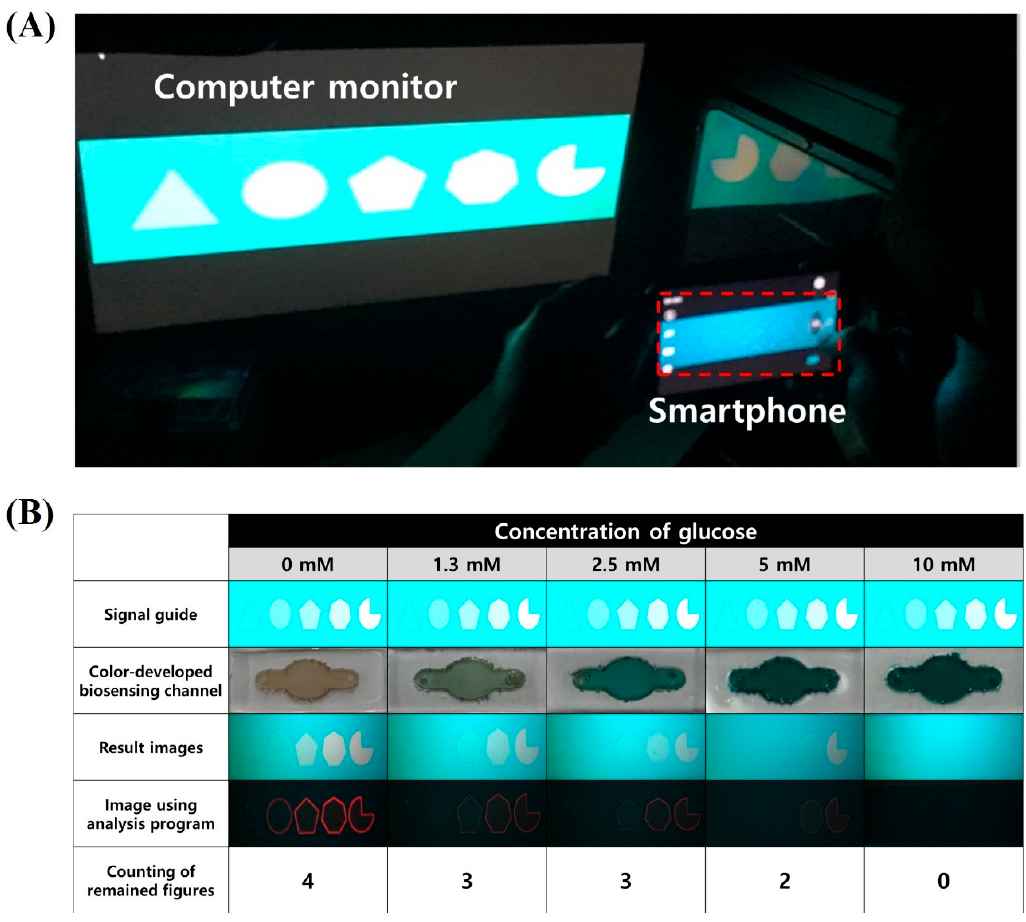
Figure 6. The glucose analysis based on the newly developed biosensing principle: ( A ) an image of application of the new biosensing system to a computer monitor; and ( B ) the resulting images of biochemical reactions at various glucose concentrations in the sample (0, 1.3, 2.5, 5, or 10 mM) after GOx/HRP catalysis. The smartphone-based quantitative analysis was conducted by naked-eye observation, and computational calculation was implemented to provide accurate counting.